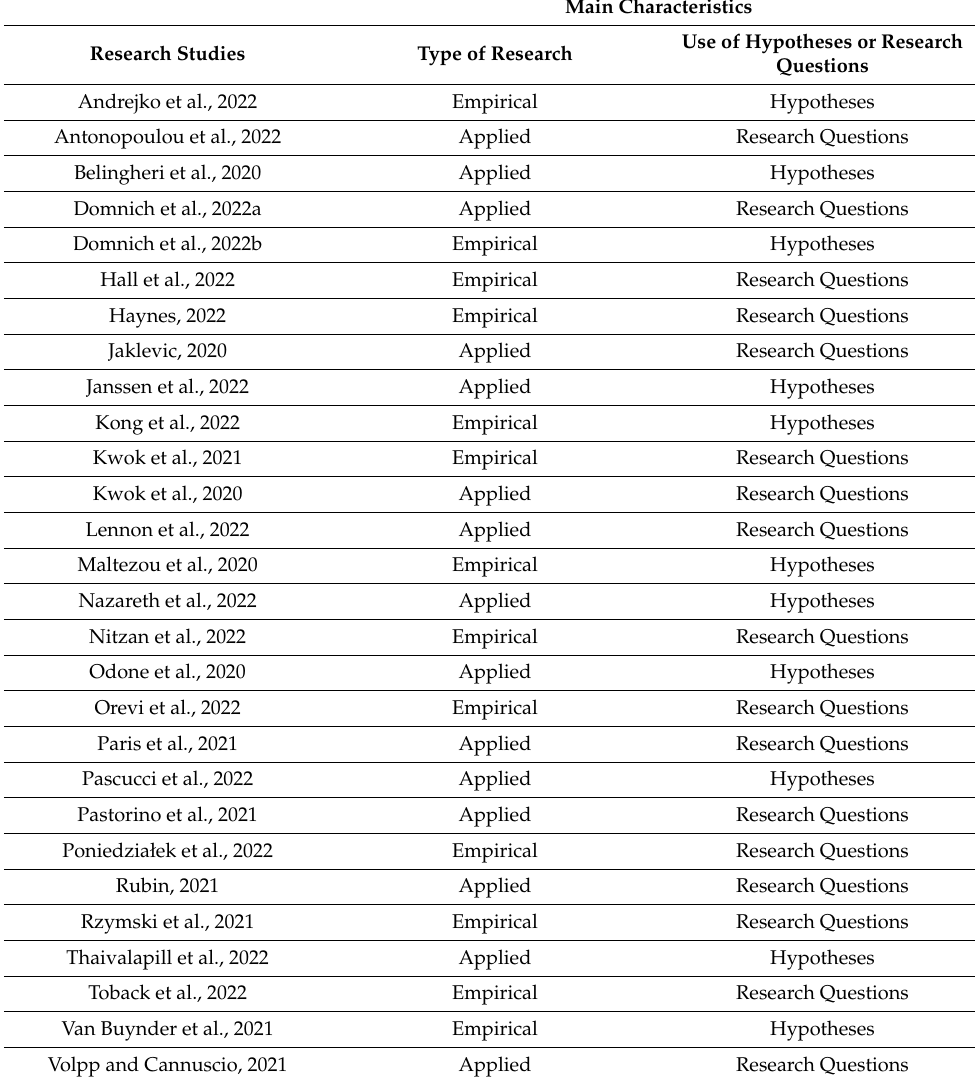
Table 1. Main characteristics of the research studies used